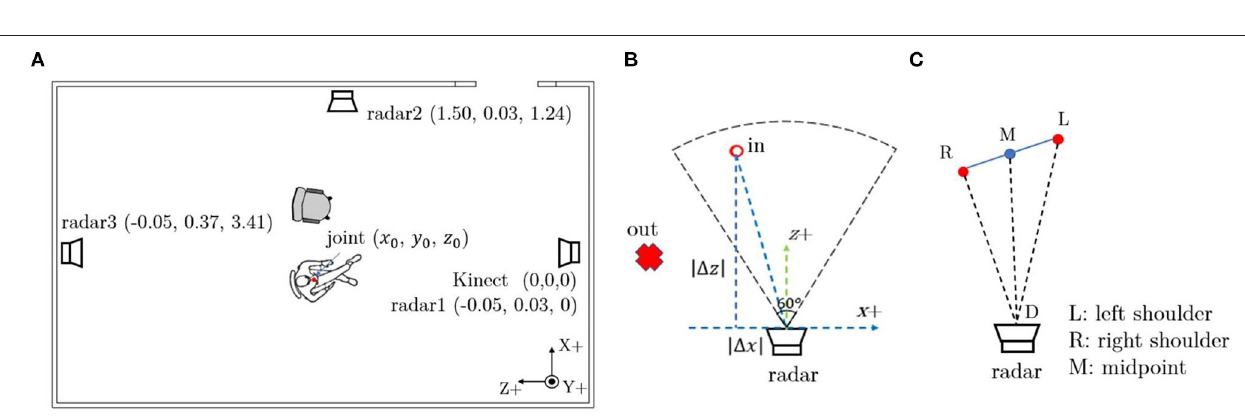
FIGURE 3 | (A) Joints and skeletons detected and visualized by the Azure Kinect Tracking Viewer when a human subject was sitting on a chair. (B) The Kinect frame is rotated about x-axis by an angle A (solid lines: reference frame; dash lines: rotated frame).